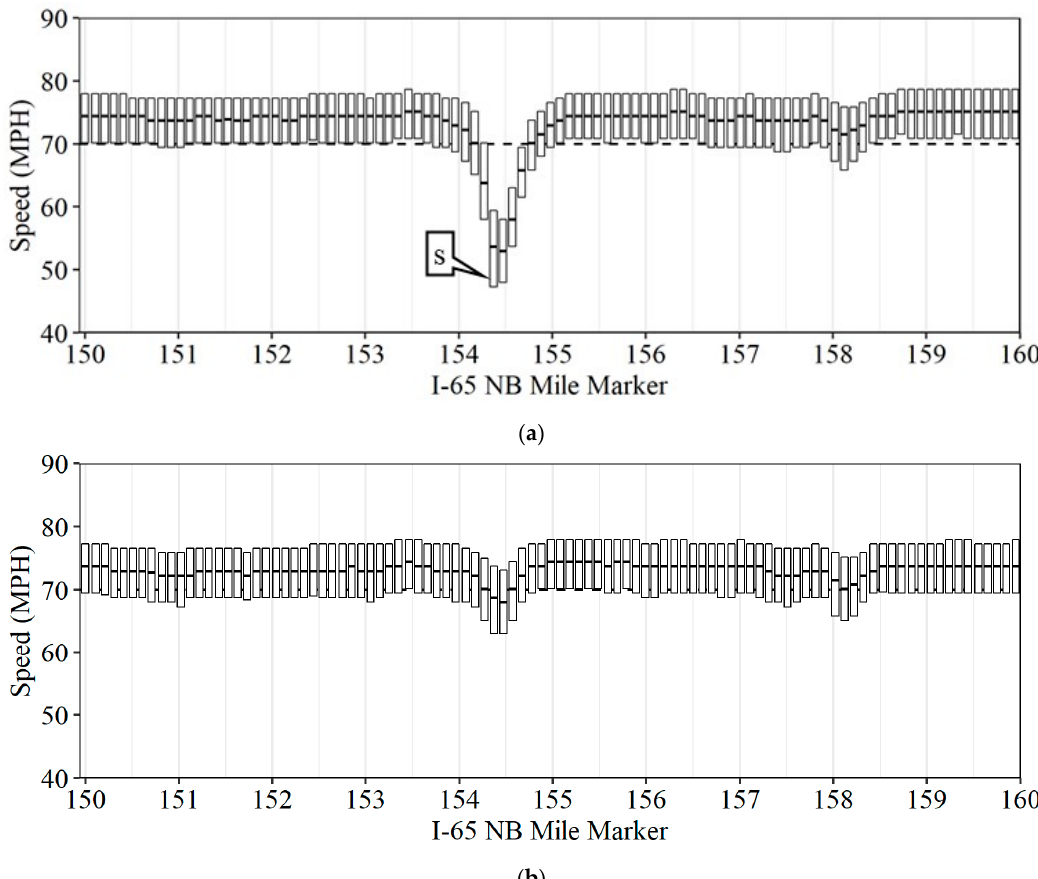
Figure 14. I-65 NB around MM 154.4 at Manson and Colfax.